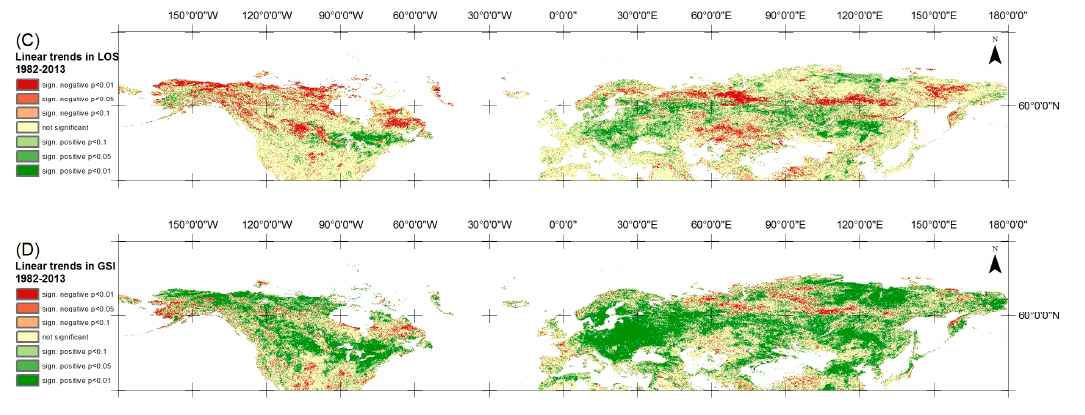
Figure 2. Linear trends in vegetation phenology and growing season integral 1982–2013. ( A ) Linear trends in SOS. ( B ) Linear trends in EOS. ( C ) Linear trends in LOS. ( D ) Linear trends in GSI. Note: positive trends indicate delaying SOS/EOS dates whereas negative trends denote advancing SOS/EOS dates.